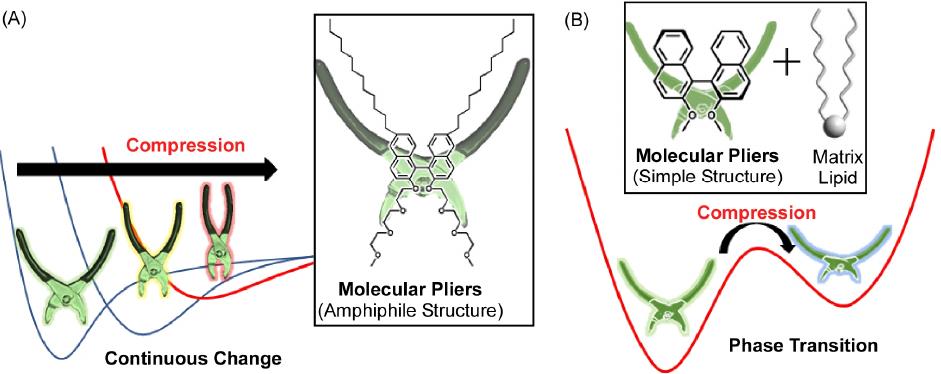
Figure 20. Controls of binaphthyl-type molecular pliers at the air-water interface: (A) continues change; (B) phase-transition-based digital change.